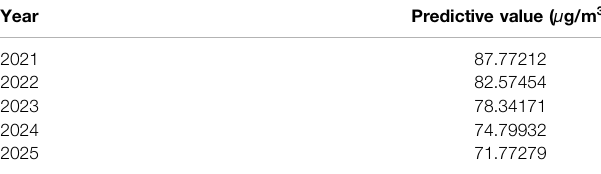
TABLE 4 | PM 2.5 forecast results.